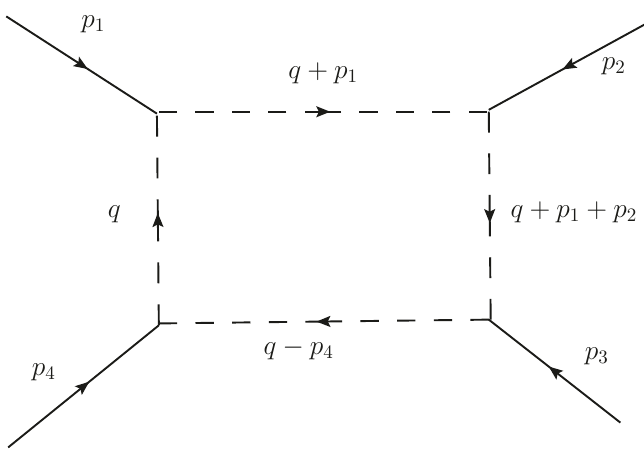
Figure 15. This diagram de(cid:12)nes W ( p 1 ; p 2 ; p 3 ; p 4 ) in